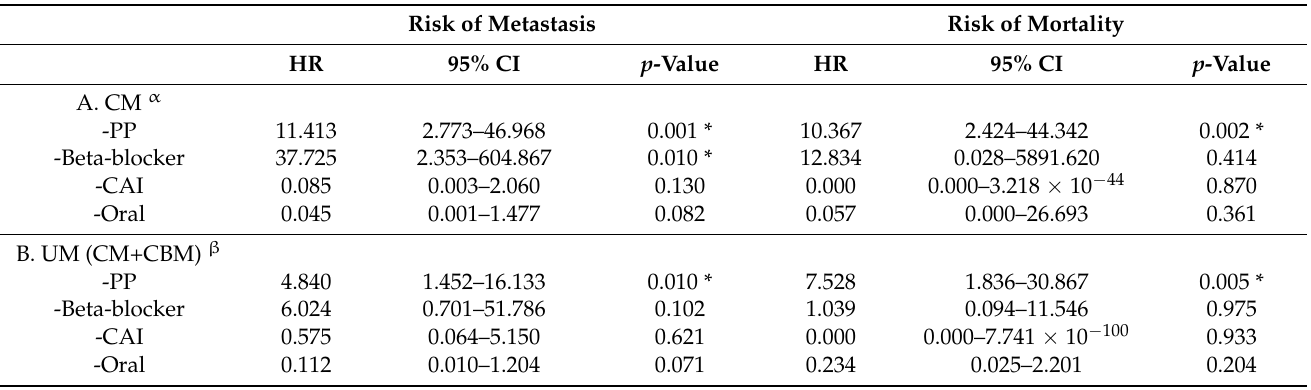
Table 2. Risk of metastatic choroidal- and uveal melanoma and mortality. Presented as hazard ratio with corresponding 95% confidence interval and p -value. Risk of Metastasis Risk of Mortality